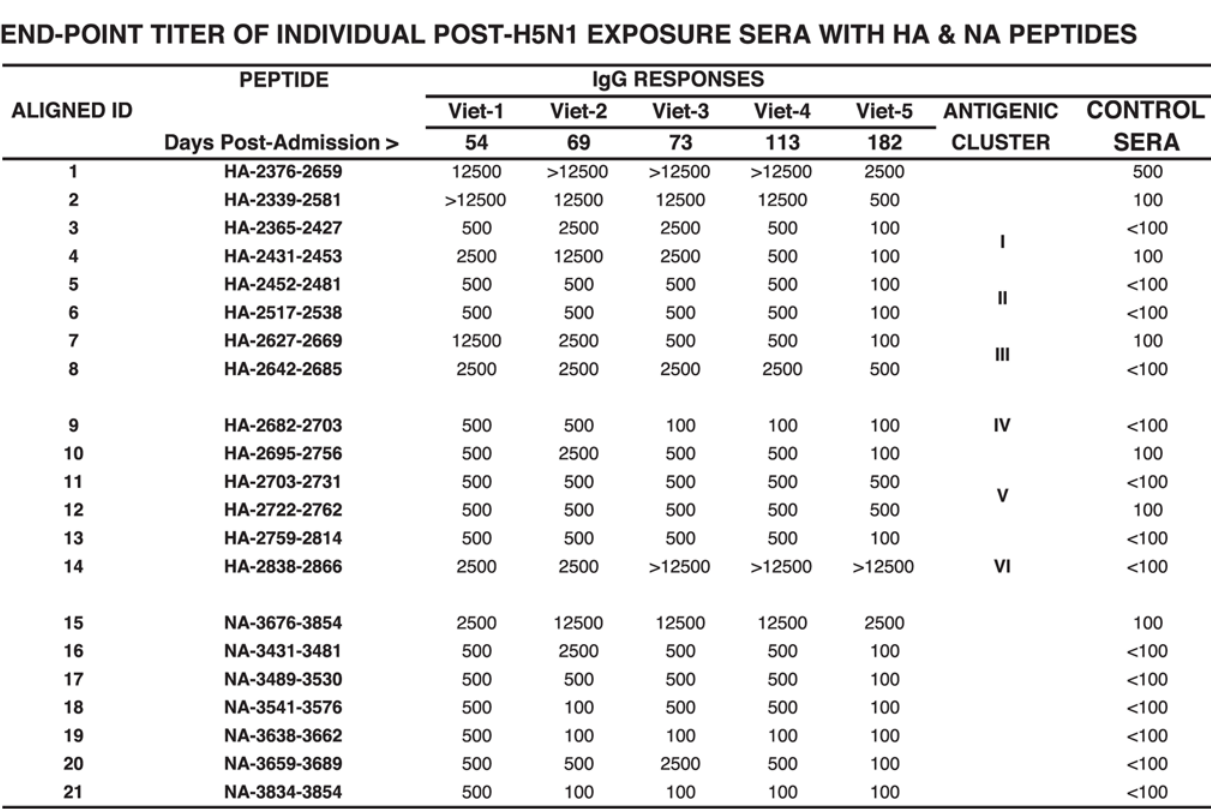
Figure 3. Elucidation of the epitope profile in HA and NA proteins recognized by antibodies in individuals that survived H5N1 infections in Vietnam. (A) Alignment of peptides recognized by pooled sera from H5N1-infected individuals identified using H5 (HA + NA) GFPDL. Bars with arrows represent the identified inserts in 5 9 –3 9 orientation. Numbered segments represent inserts that were selected with high frequencies